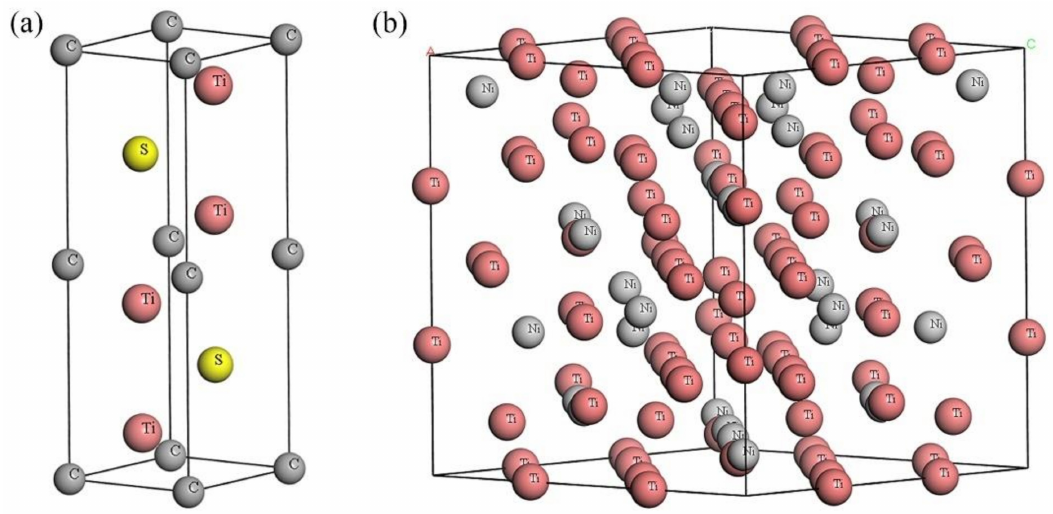
Figure 8. The crystal structures: ( a ) Ti 2 SC, ( b ) Ti 2 Ni.